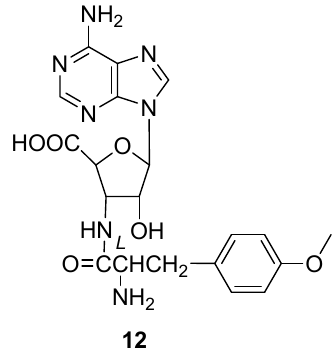
Figure 5. Structure of alkaloid 12 [14].